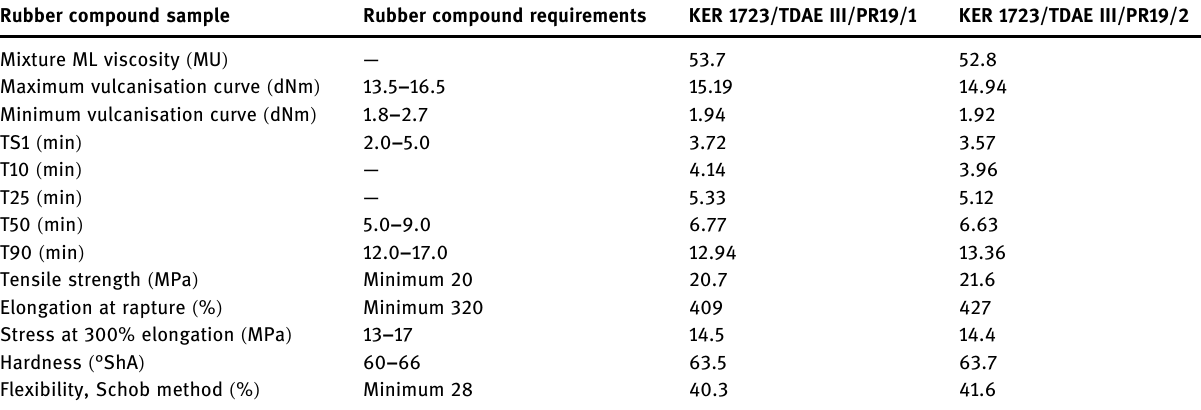
Table 10: Physicomechanical properties of the rubber compound based on the KER 1723/TDAE III/PR19/1 and the KER 1723/TDAE III/PR19/2 Rubber compound